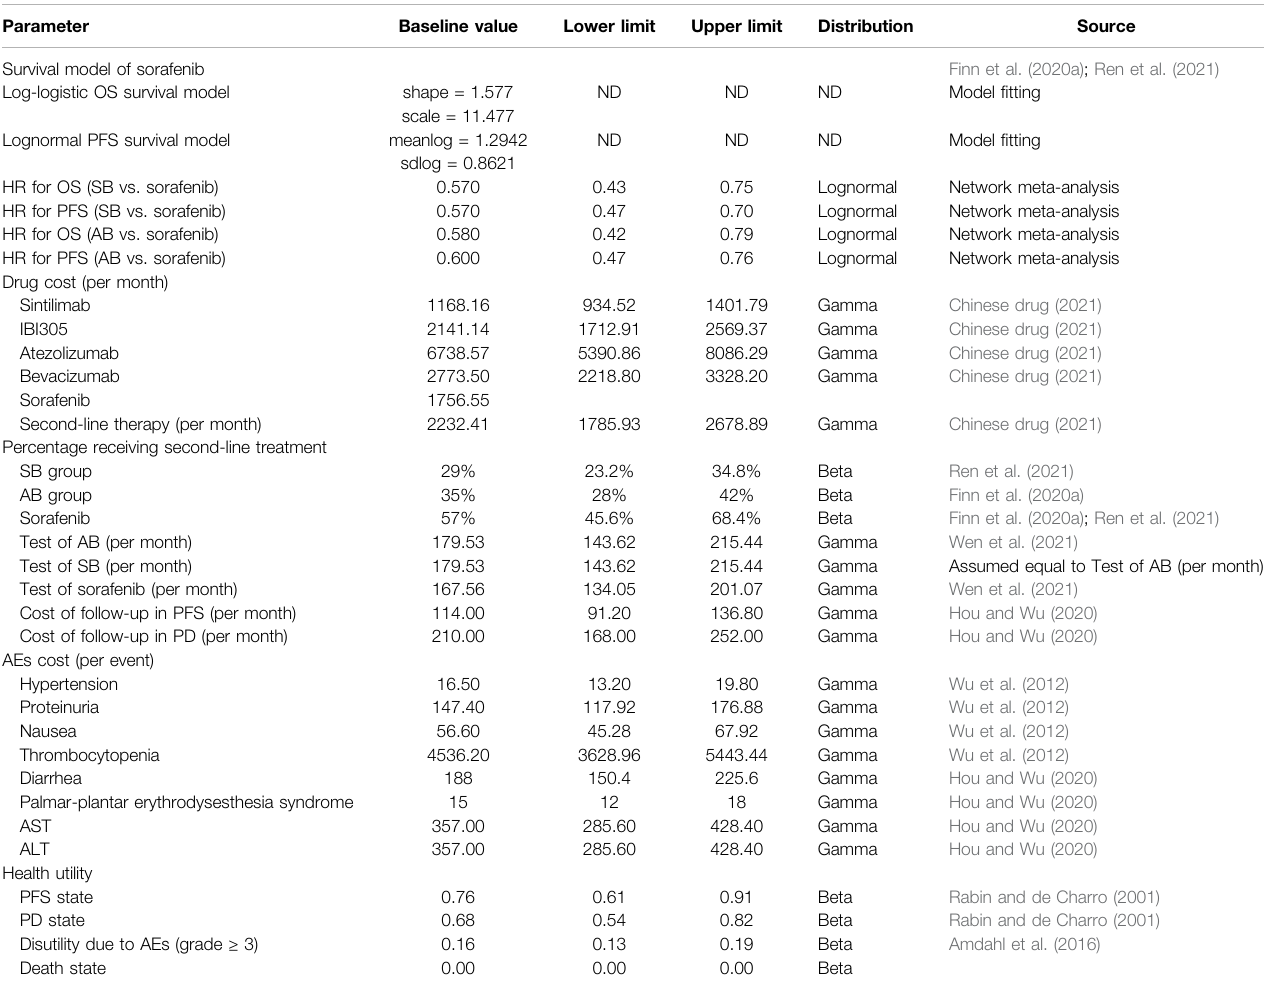
TABLE 1 | Input parameters of the model.